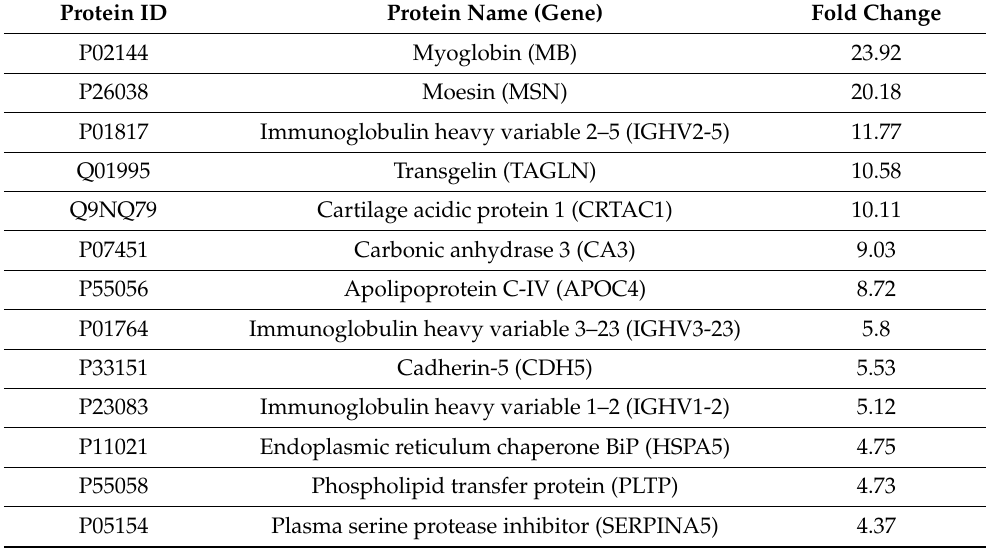
Table 3. Identified serum proteins with significantly differential abundance (top 20 proteins with upregulation and downregulation) in AAD serum compared to that in AMI serum.